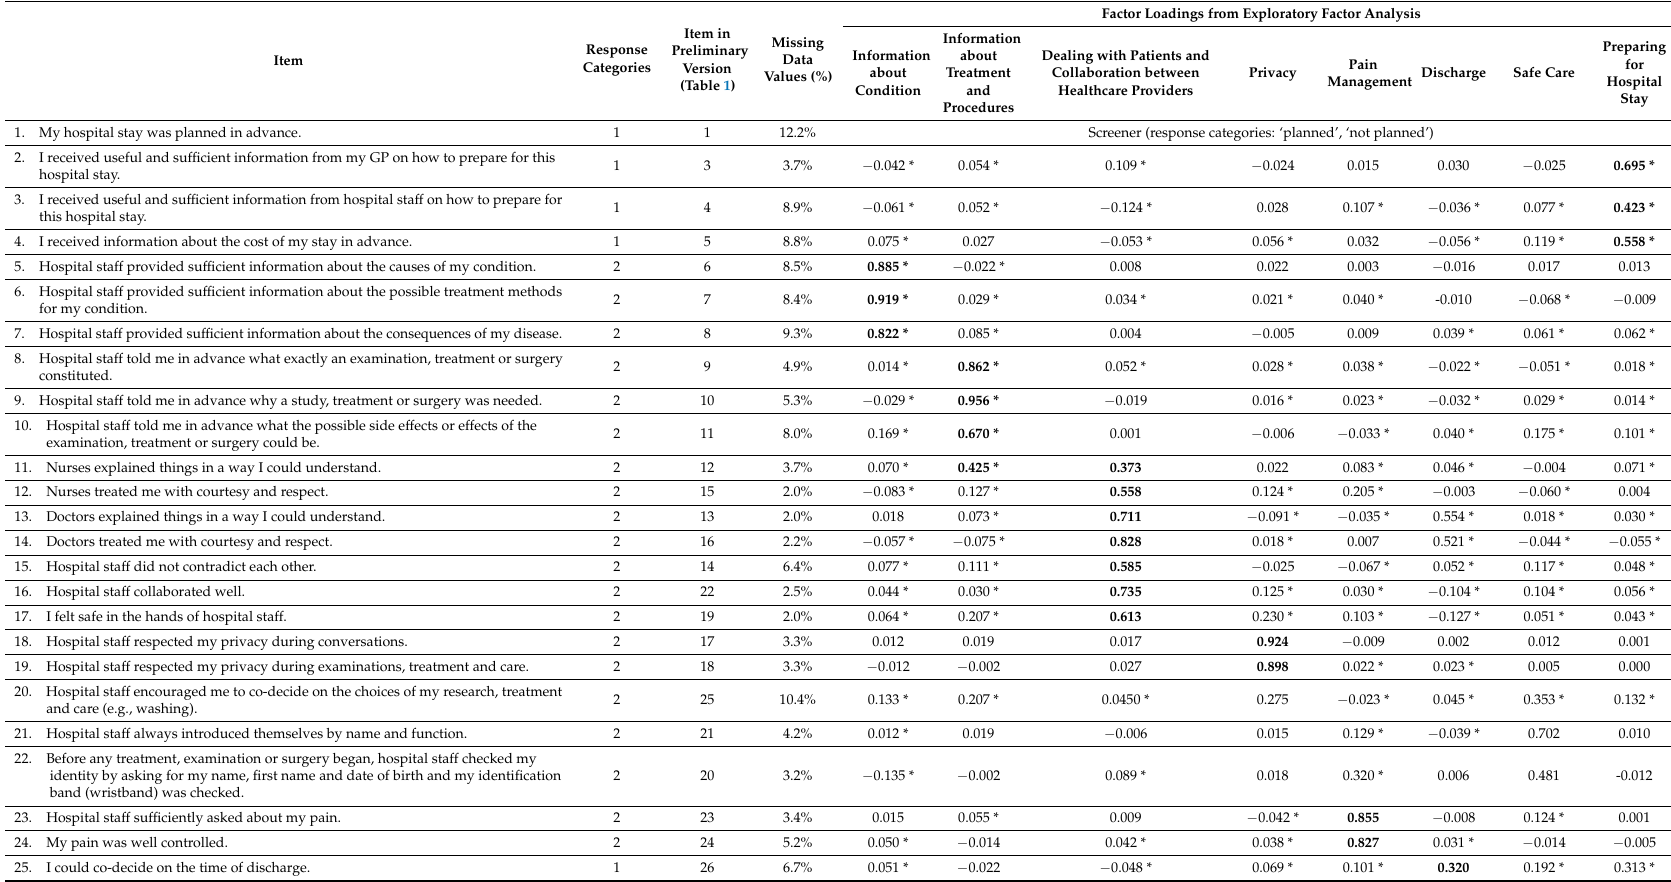
Table 2. Exploratory factor analysis for the modified version of the Flemish Patient